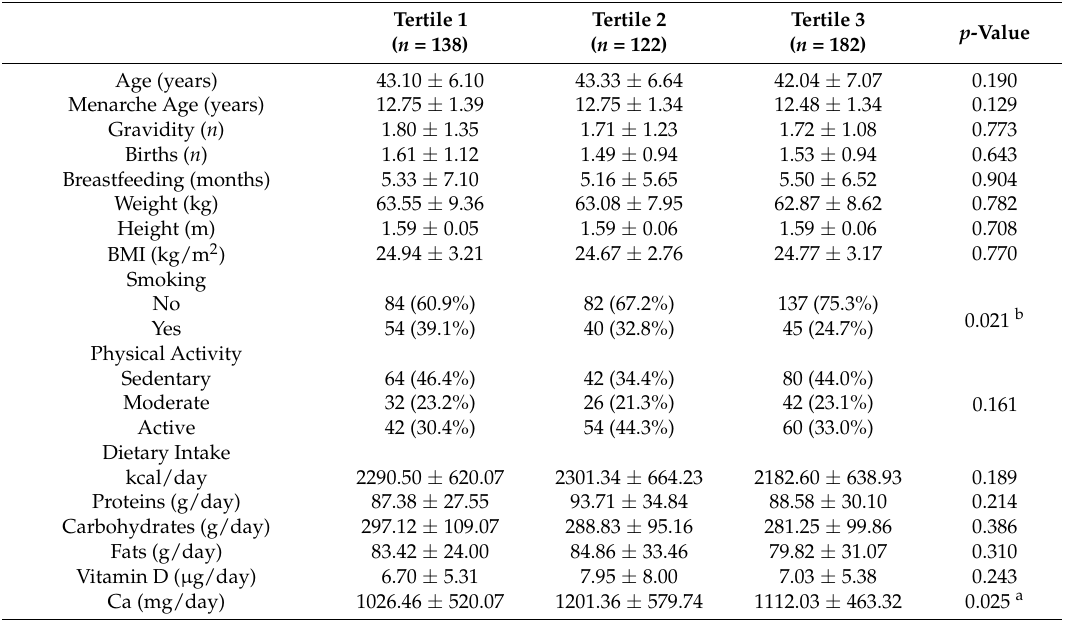
Table 1. Biological, anthropometric, and dietetic factors in the study according to tertile of Mediterranean diet